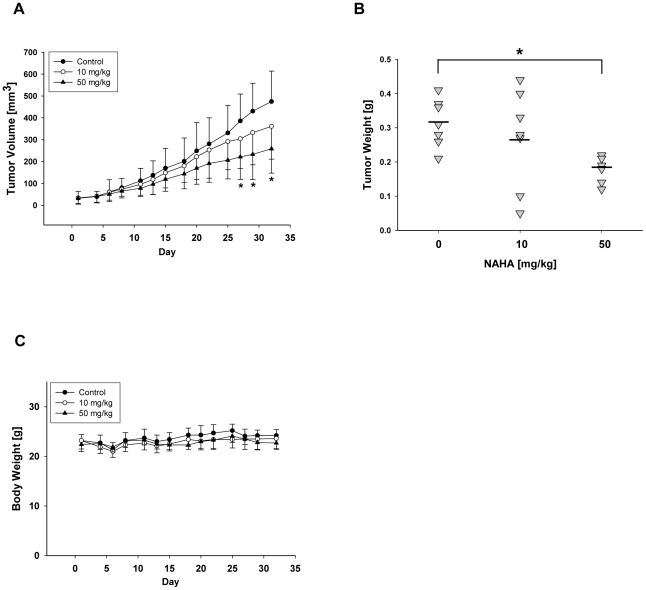
NAHA inhibits growth of breast cancer cells in vivo.(A) Tumor volume. MDA-MB-231 cells were inoculated s.c. in the right flank of each mouse. Seven days after inoculation, mice were randomly divided into 3 groups (n = 10) and treated with NAHA (i.p., 10 mg or 50 mg/kg of body weight/3 times per week) or vehicle (n = 11) for 32 days. Tumor volume was measured three times a week. Data are mean ± SD, * significantly different from control (p<0.05) using a two-sample Student t-test. (B) Tumor weight, * p<0.05. (C) Body weight of mice.